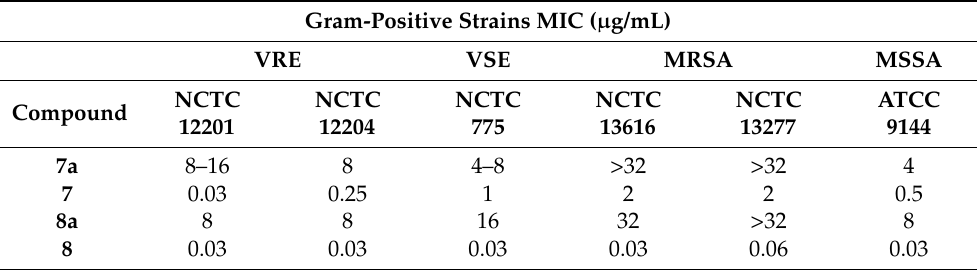
Table 1. MIC result against tested Gram-positive strains for compounds 7, 7a, 8, and 8a. Results in µ g/mL, at least three replicates each.